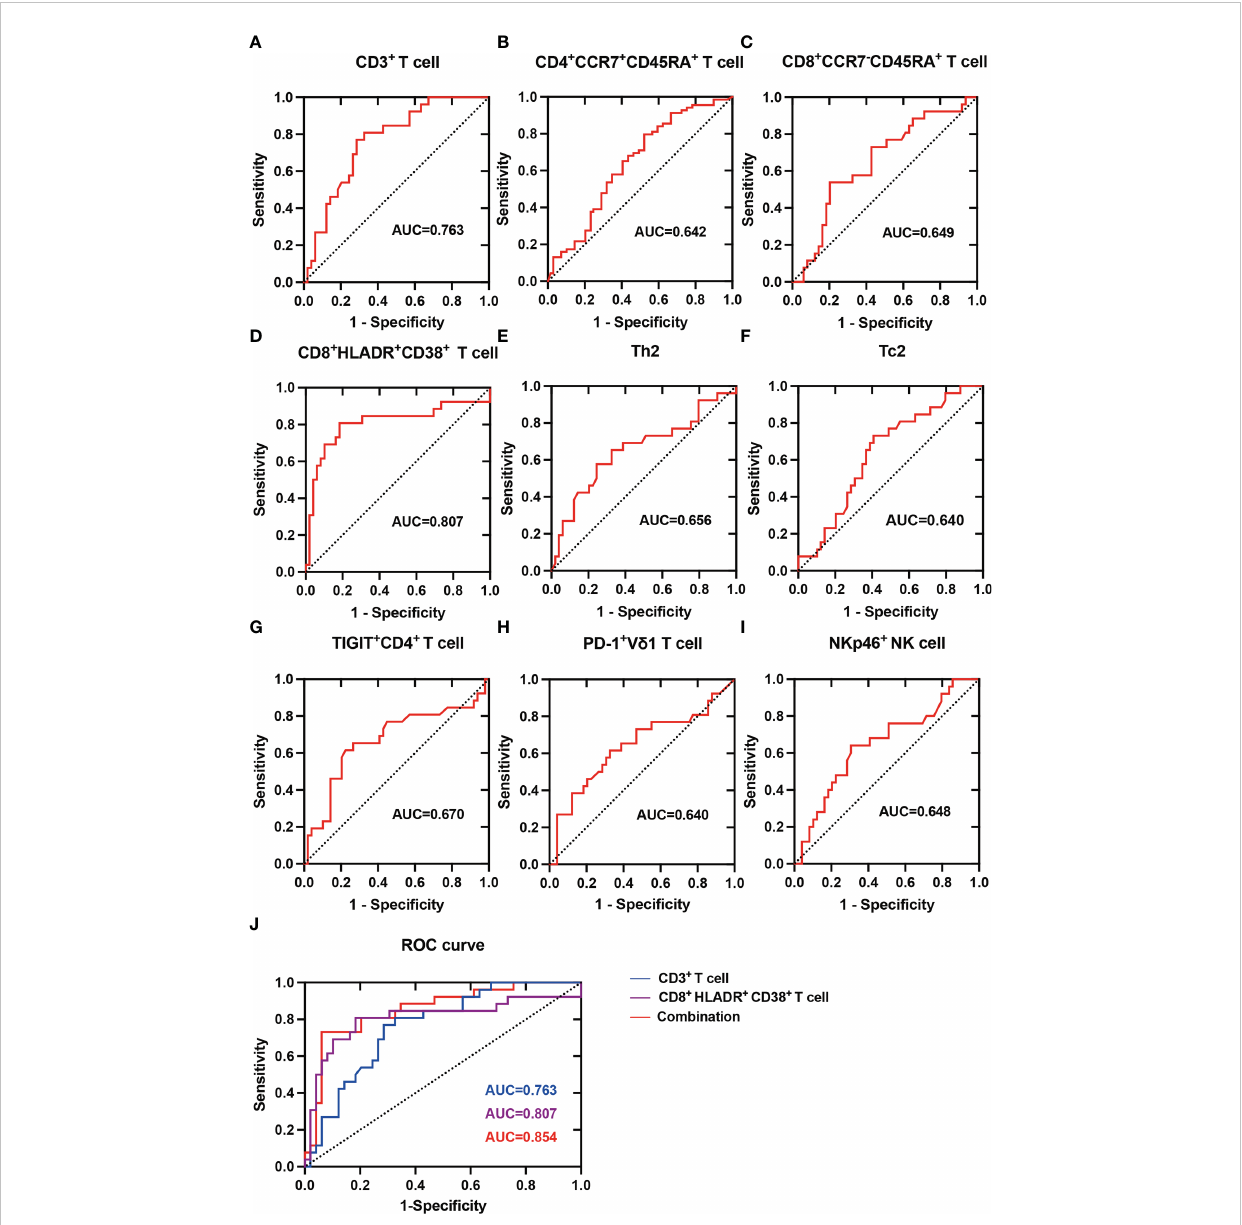
FIGURE 9 ROC analysis of Peripheral circulating lymphocytes in predicting HBV-HCC. (A) ROC curve for the frequency of CD3 + T cell as a predictor of HBV- HCC. (B) ROC curve for the frequency of CD4 + CCR7 + CD45RA + T cell as a predictor of HBV-HCC. (C) ROC curve for the frequency of CD8 + CCR7 - CD45RA + T cell as a predictor of HBV-HCC. (D) ROC curve for the frequency of CD8 + HLADR + CD38 + T cell as a predictor of HBV-HCC. (E) ROC curve for the frequency of Th2 as a predictor of HBV-HCC. (F) ROC curve for the frequency of Tc2 as a predictor of HBV-HCC. (G) ROC curve for the frequency of CD4 + TIGIT + T cell as a predictor of HBV-HCC. (H) ROC curve for the frequency of PD-1 + V d 1 T cell as a predictor of HBV-HCC. (I) ROC curve for the frequency of NKp46 + NK cell as a predictor of HBV-HCC. (J) ROC curve for the frequency of CD3 + T cell, CD8 + HLADR + CD38 + T cell and the combination of both as a predictor of